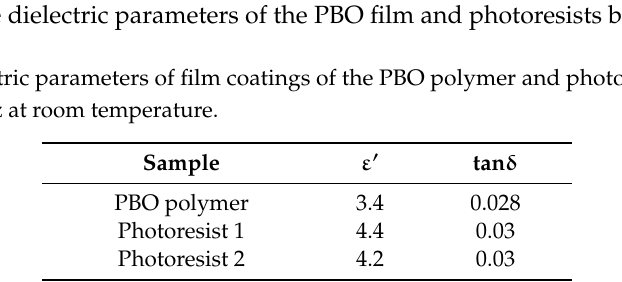
Table 2. The dielectric parameters of film coatings of the PBO polymer and photoresists based on it, measured at 1 MHz at room temperature.